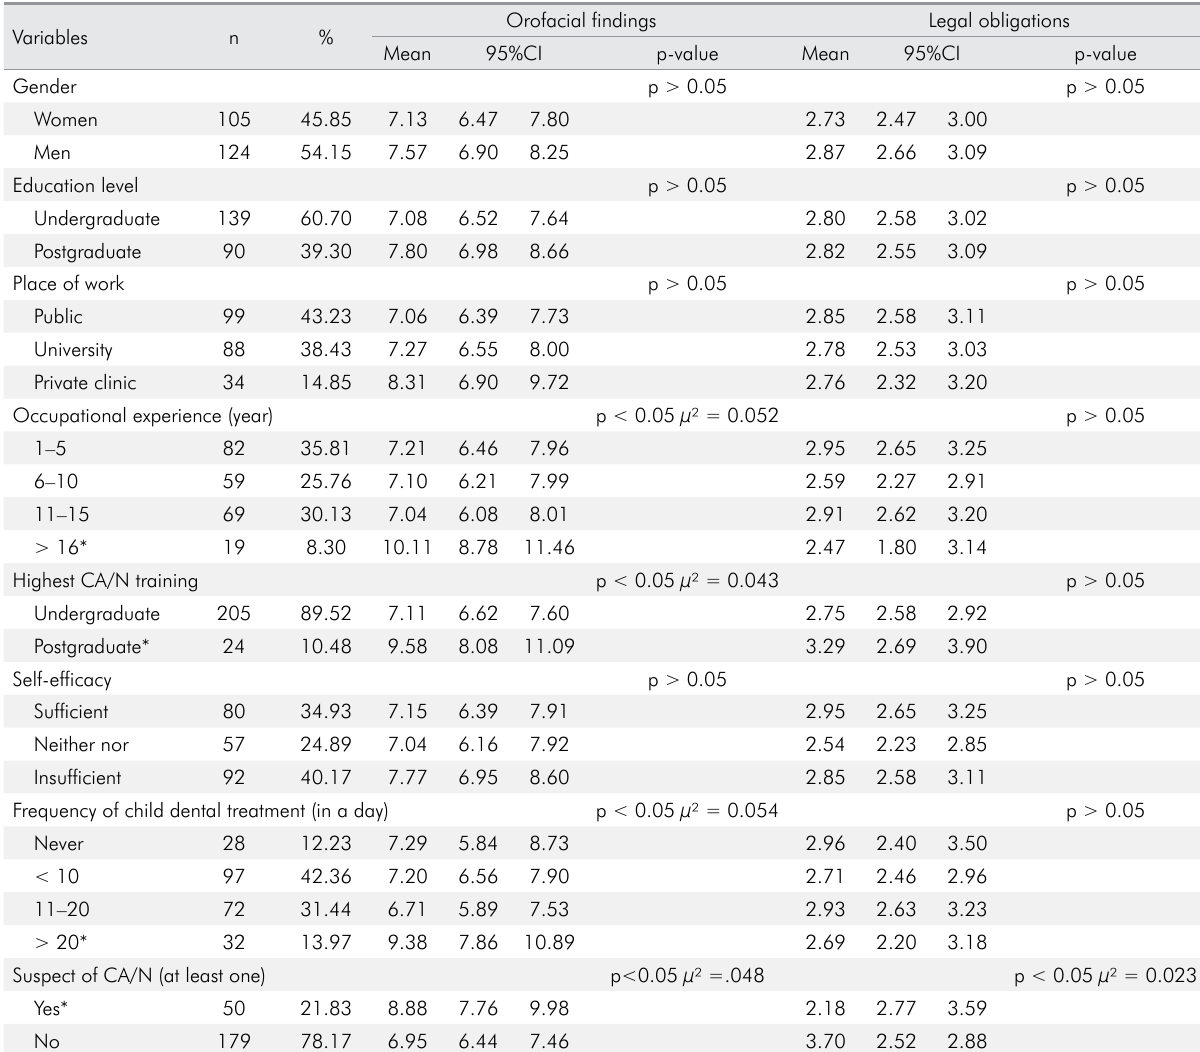
Table 1. Comparison of mean scores of knowledge about legal obligations and orofacial characteristics and findings that are indicative of child abuse and neglect (CA/N) by all participants and